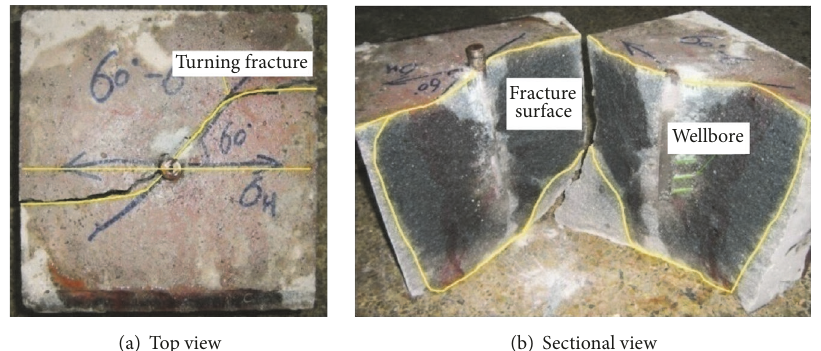
Figure 19: Experimental result of Chen et al. [38].